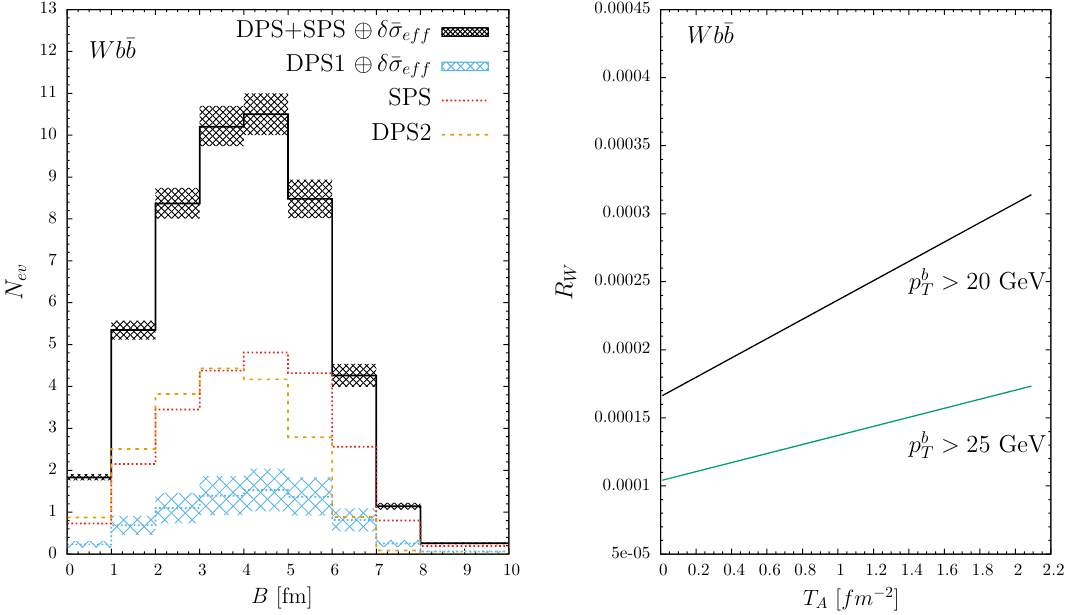
(cid:4) > 20 GeV (left). The ratio R L dt = 0 . 1pb − 1 and for p j T